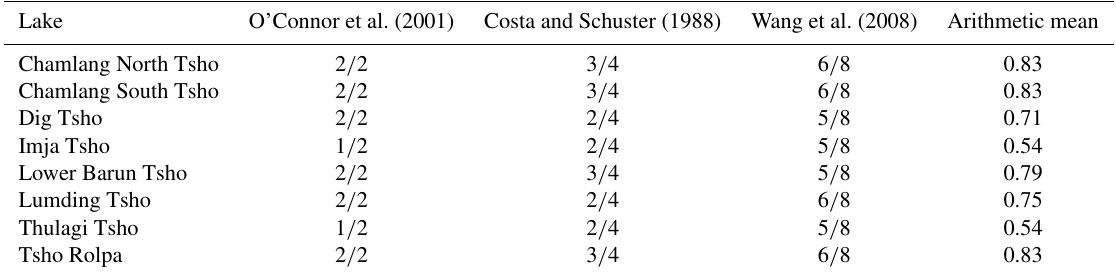
Table 1. Previous qualitative hazard assessments applied to eight glacial lakes in Nepal. Fractions are the number of hazard parameters identified out of the total number of parameters used by each method. Details shown in Tables S.1–S.3.